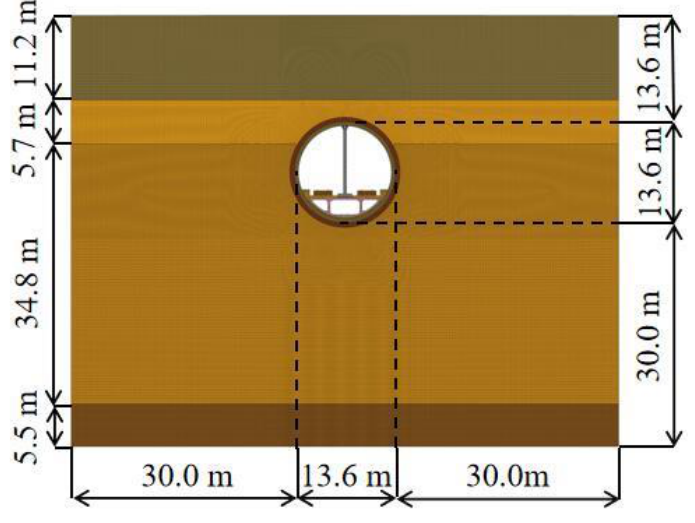
Figure 2. Soil – tunnel model. Figure 2. Soil–tunnel